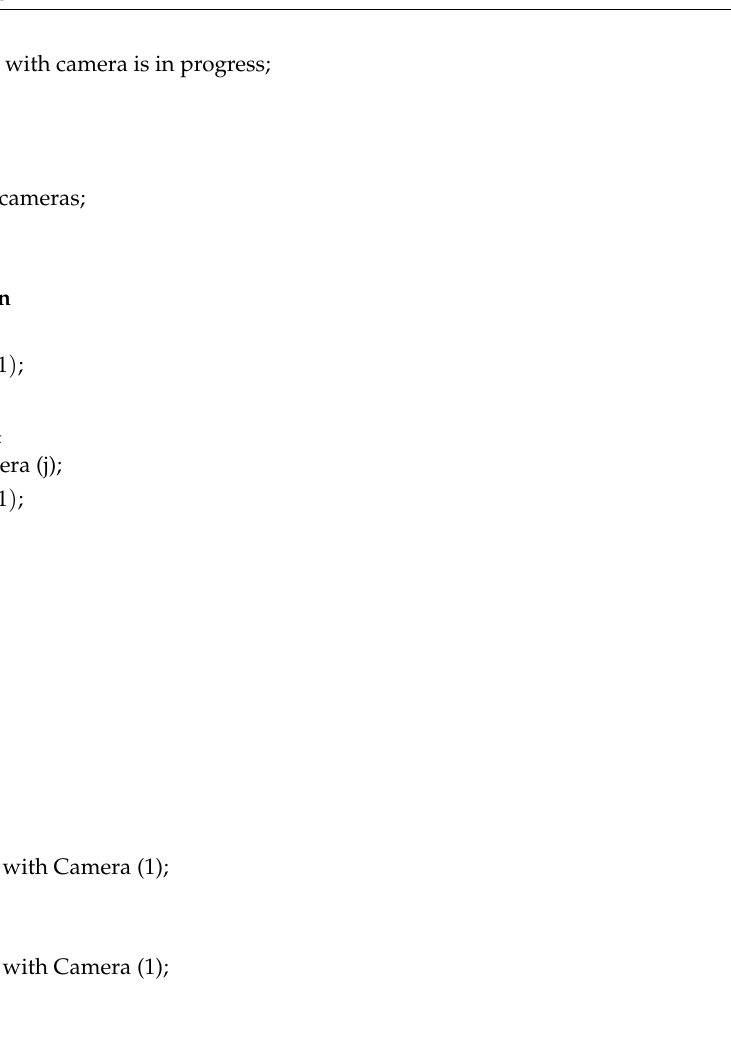
Algorithm 3: Network-switching algorithm from OCC to